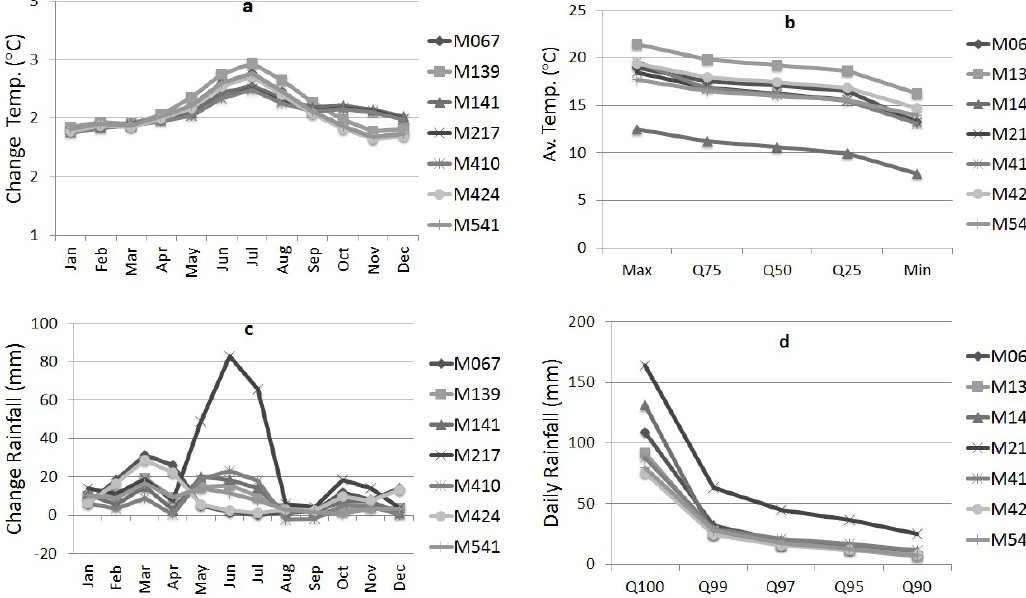
Fig. 7. Temperature and rainfall properties obtained from the average of ensemble downscaled series (2045–2065). (a) Monthly average temperature distribution, (b) monthly temperature for different quantiles, (c) monthly rainfall depth distribution, (d) daily rainfall depth for different quantiles.